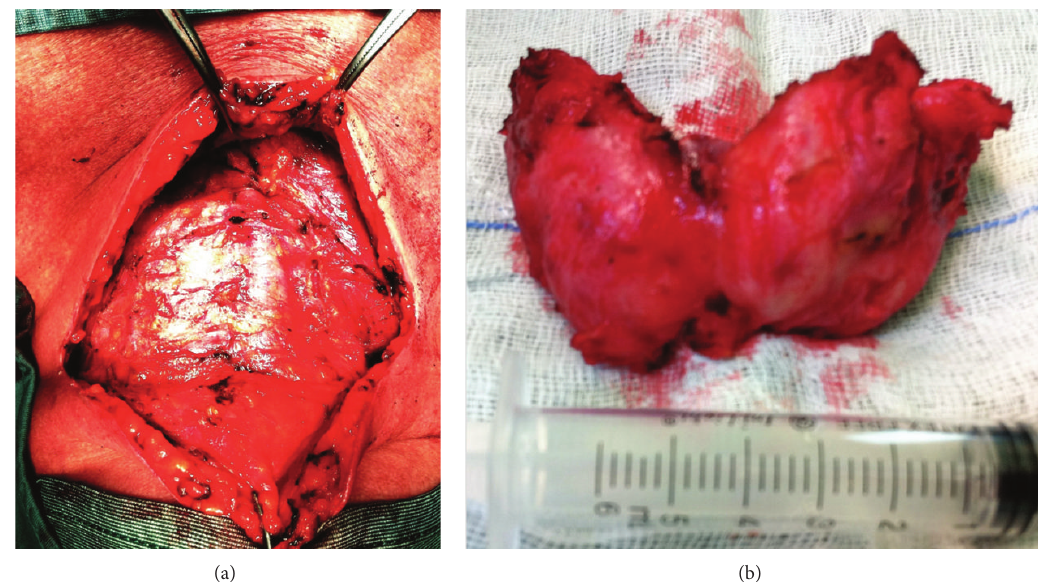
Figure 1: A macroscopic photograph. (a) Intraoperative image of the prethyroid muscular layer. (b) Thyroidectomy